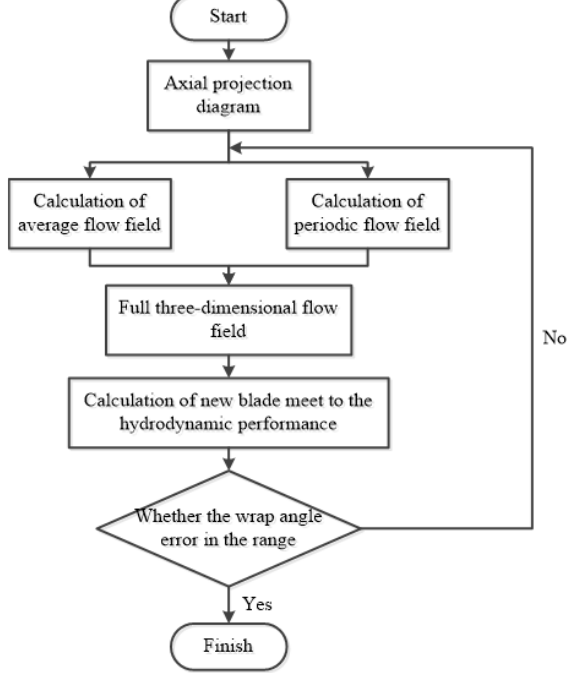
Figure 25. The flowchart of inverse design